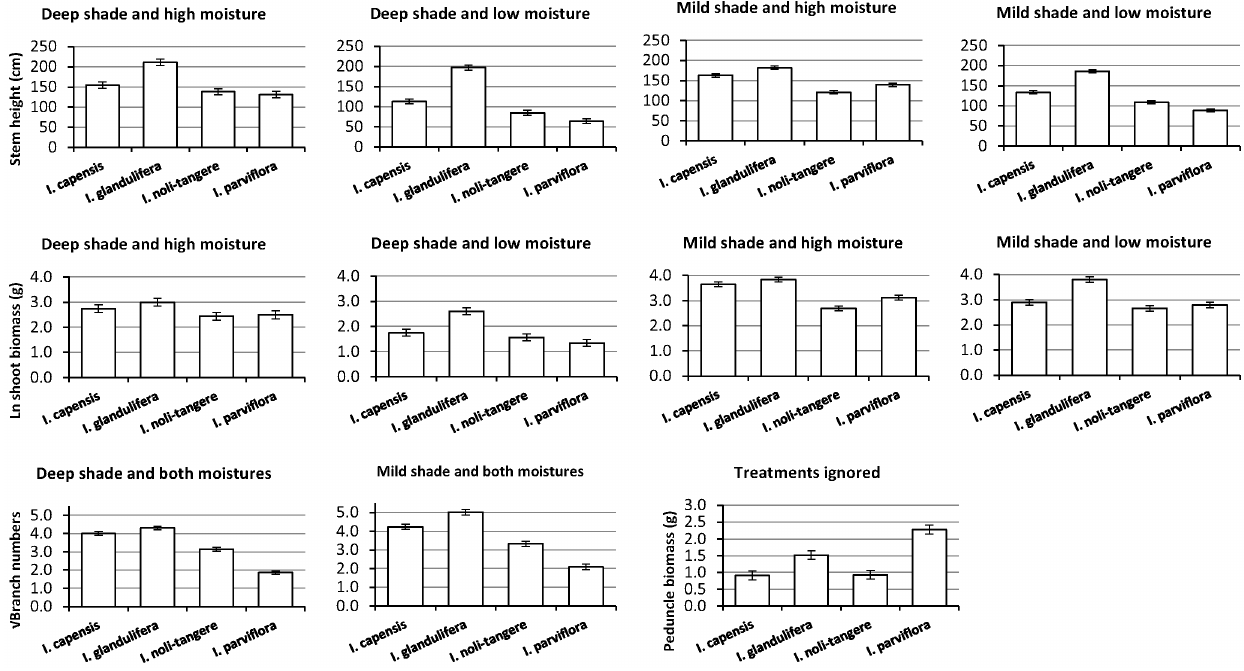
Figure 1. Comparison of stem height, shoot biomass, branch number, and peduncle biomass for Impatienscapensis , I.glandulifera , I. noli-tangere and I.parviflora in the first experiment. Note that because some values on peduncle biomass were negative on the logarithmic scale, they were back transformed to the original scale to ease visualisation; the LSD bars are slightly asymmetric due to the back transformation. Treatments are ignored if the highest level interaction for the analysed subset of the data was significant and the model thus could not be further simplified for the individual levels of the factors. Otherwise, the species are evaluated separately for each level of each factor that appeared significant. In case of significant interactions between the treatments, the pattern of bars differs for each level of each treatment. Bars of mean species values whose 95% least square differences (LSD) intervals do not overlap are significantly different.